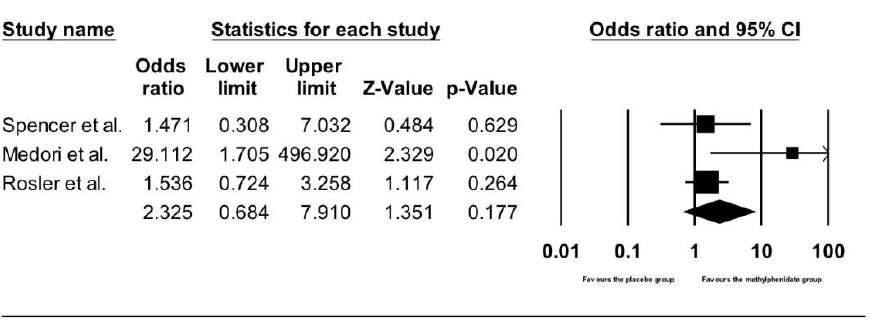
Figure 6. Forest plot on number of adverse cardiac events in adults receiving methylphenidate treatment and placebo.